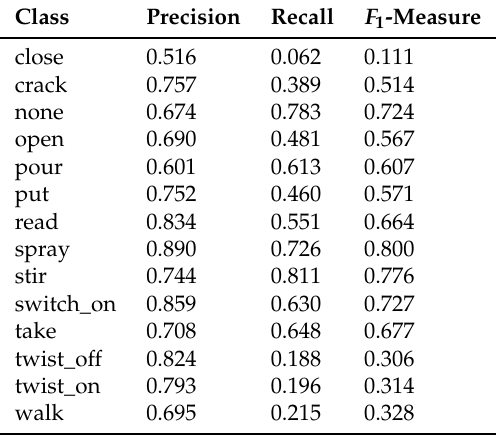
Table 5. A closer look at our best performing configuration for the classes in the CMU-MMAC dataset. The model was learned in a 10-fold cross-validation among all subjects.